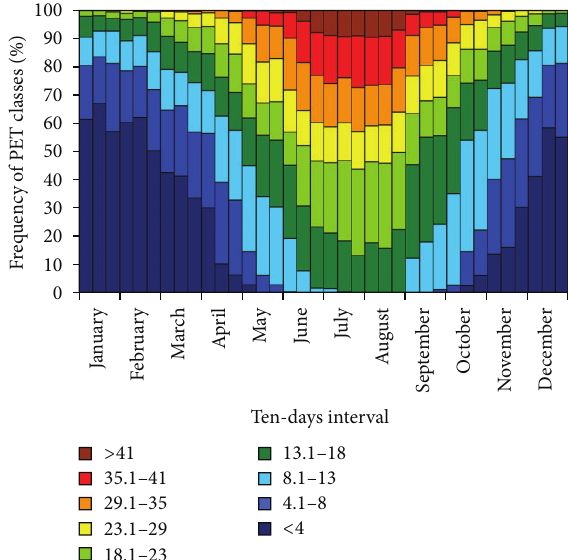
Figure 3: Bioclimatic diagram for Athens University Campus for the period 1999–2007; frequencies (%) of the nine PET classes for 10-day period of the mean